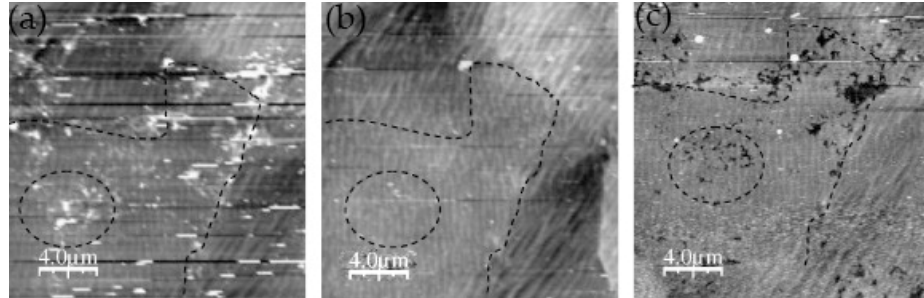
Figure 11. AFM images of the surface, taken at ( a ) open-circuit potential, ( b ) corrosion potential after cathodic scan, and ( c ) pitting potential. Reprinted with permission from Reference [46]; copyright 2008 Elsevier Ltd.